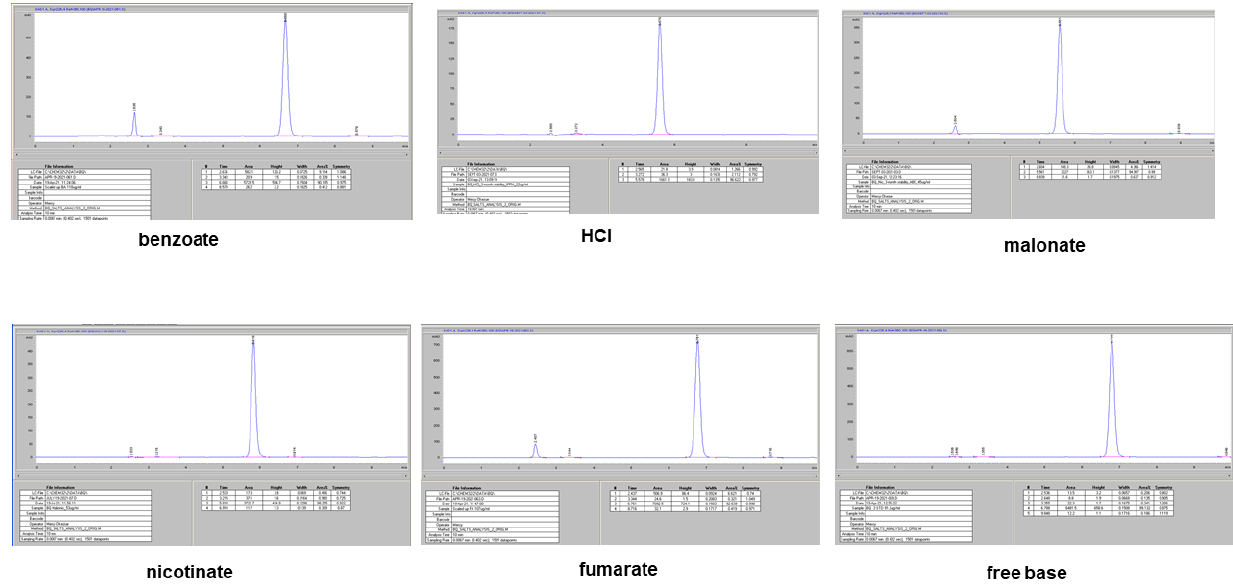
Figure 5. The HPLC retention time sfor the bedaquiline free base were similar to those of the commercially available fumarate salt and the new molecules (5.5 ± 1.2 min).